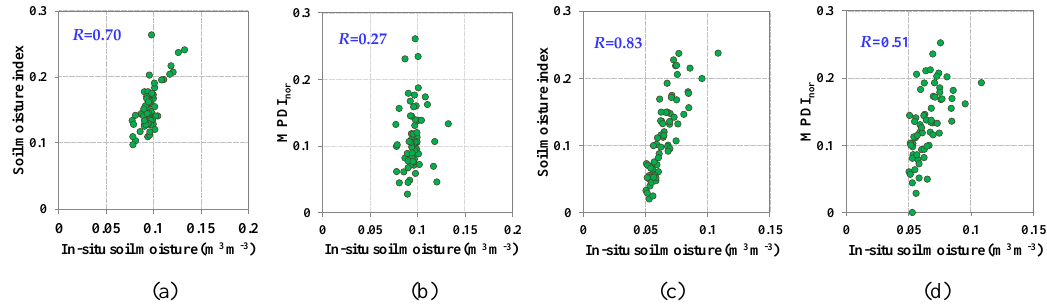
Figure 4. Scatterplot comparison of station-averaged soil moisture with SMI for (a) Naqu and (c) Pali and normalized MPDI for (b) Naqu and (d) Pali calculated by using SMAP passive observations at 36 km during the frozen period.